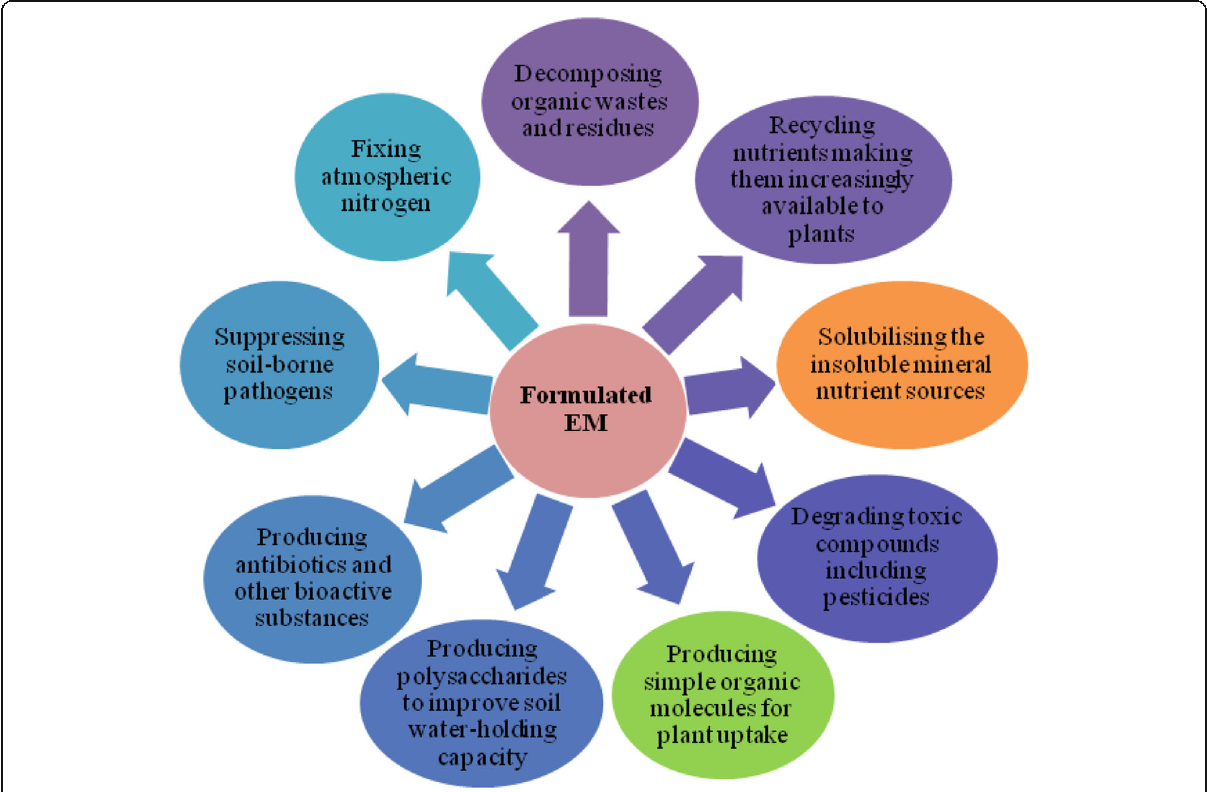
Fig. 2 Microbe-microbe and plant-microbe interactions for sustainable